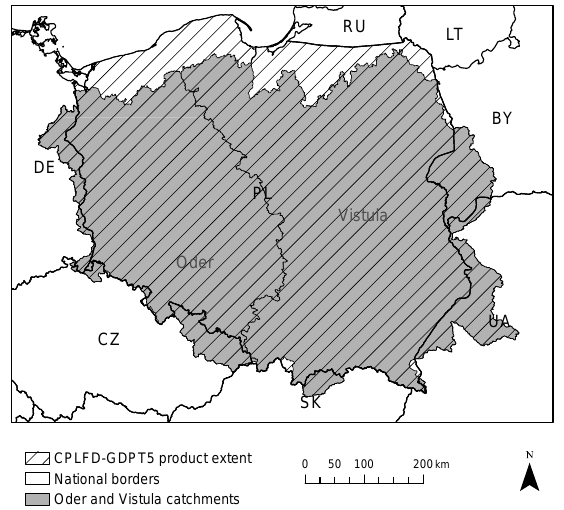
Figure 1. The spatial extent for the CPLFD-GDPT5 temperature and precipitation products. Countries are labelled with black na- tional codes. The Oder and Vistula basins are labelled in grey.